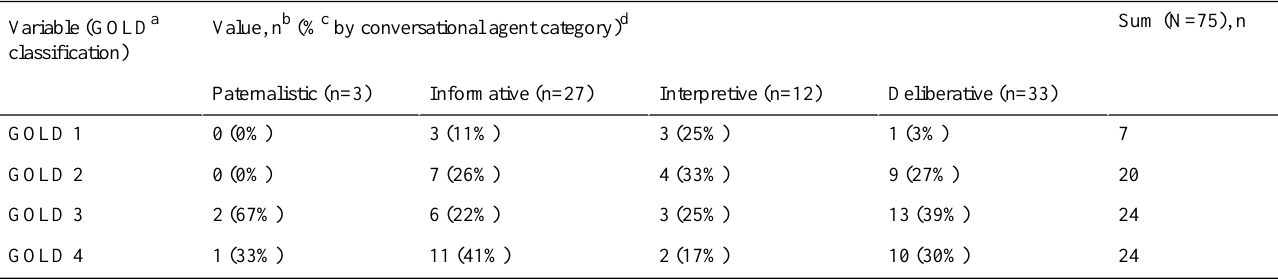
Table 5. Conversational agent preferences by Global Initiative for Chronic Obstructive Lung Disease